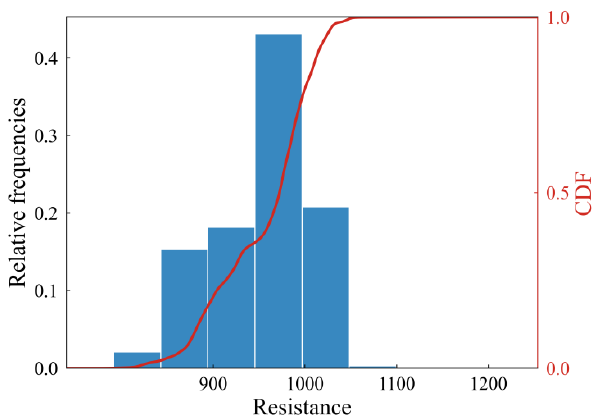
Figure 11. Distribution of structural resistance.